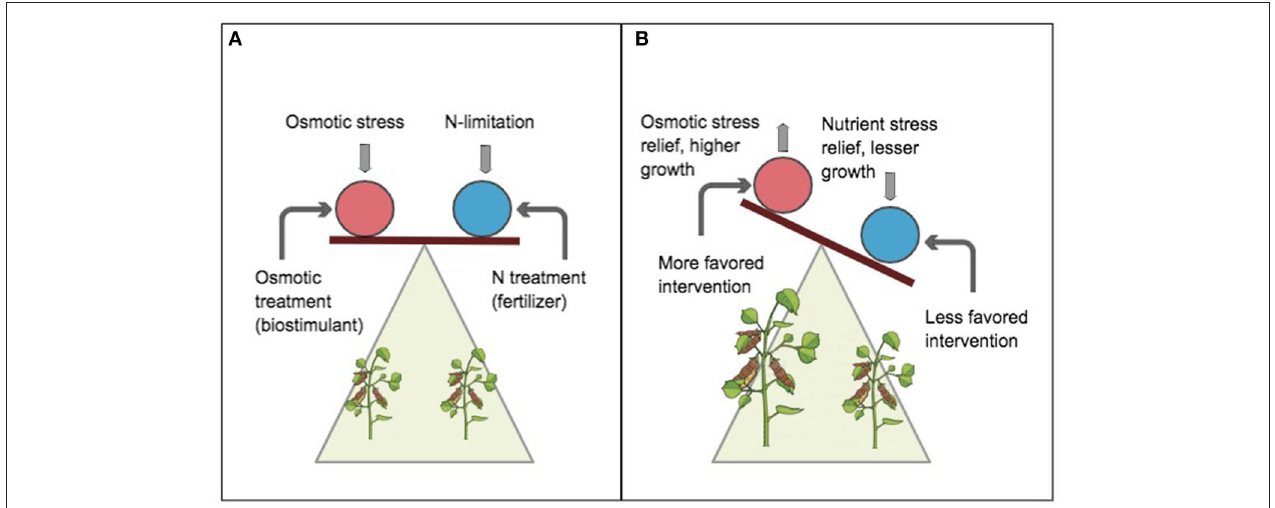
FIGURE 3 | A schematic of the limiting-stress-elimination hypothesis (LSEH). Circles represent whole-plant organisms. Balanced plane implies a notion of significance or pedigree of stress impact. Vertical arrows indicate stressors (osmotic and nitrogen limitation), downward arrow implies stress impact, and upward arrow implies relived stress. Curved arrows indicate applied intervention (exogenous biostimulant and nitrogen deposition). At equilibrium (A) , the stressor impact on productivity is assumed similar. Without any intervention, the impact of multiple stressors can be assumed to be synergetic and difficult to detect. However, when defined interventions are simultaneously applied, a shift in slope or tilt (B) distinguishes the relative magnitude of the impact of a conjected stressor and how much it limits plant productivity. The favored intervention (B) in the red circle shows sensitivity to stress response by plant and eliminates or alleviates the impact of the stressor. This results in increased productivity indicated by an upward tilt (analogous to a “lighter weighing